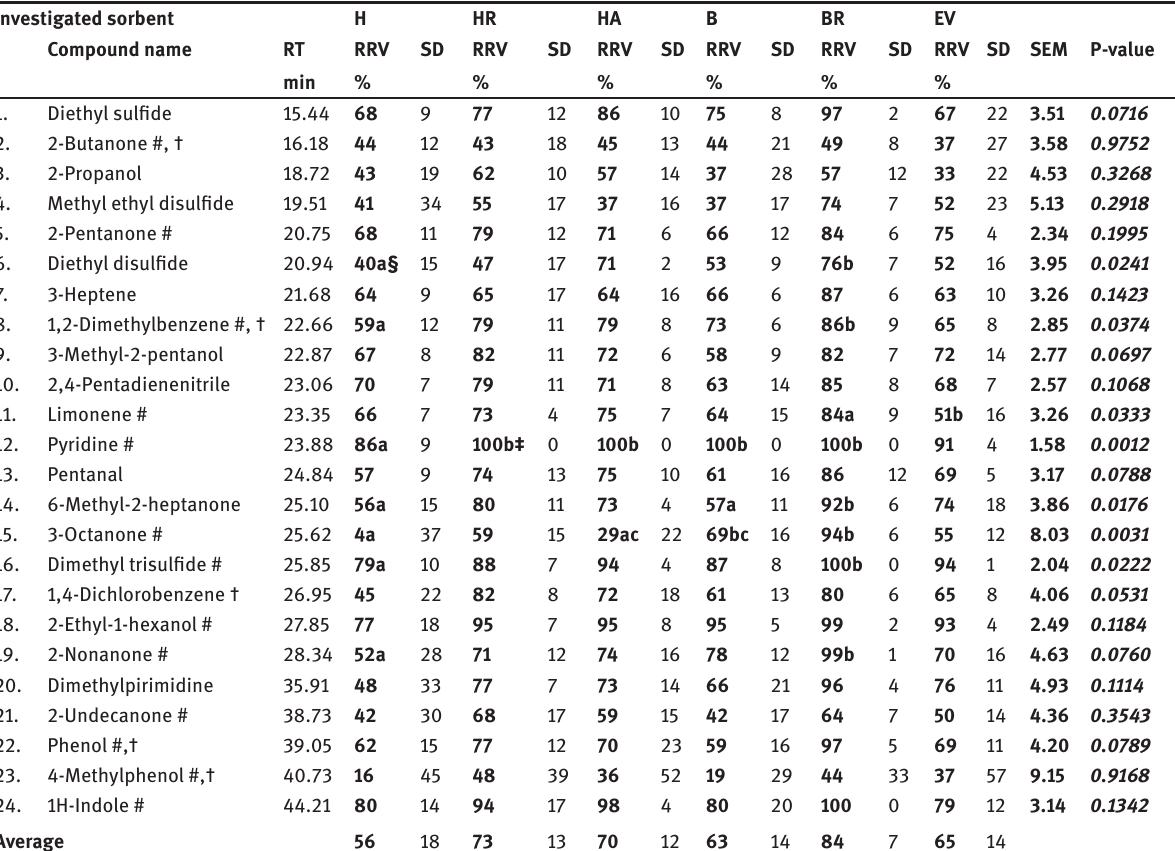
Table 2: Effect of investigated aluminosilicates on relative reduction values of tentatively identified compounds (mean, n = 3). Investigated